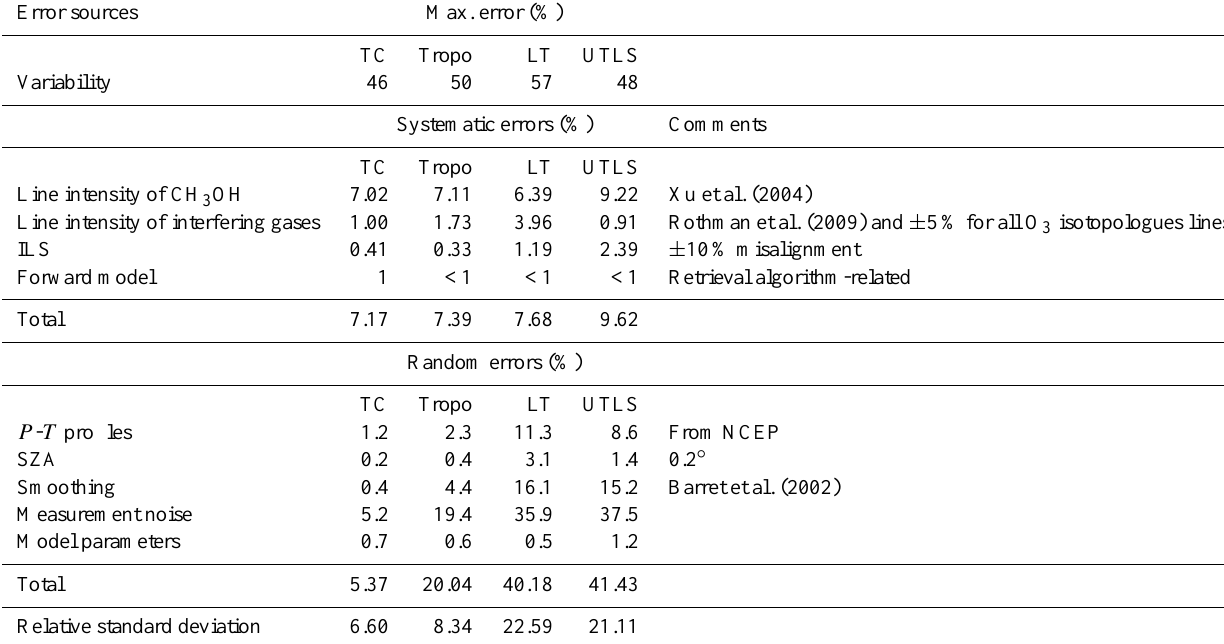
Table 1. Error budget for total and all three partial columns. TC: total column, Tropo: tropospheric column, LT: lower tropospheric layer, UTLS: upper troposphere/lower